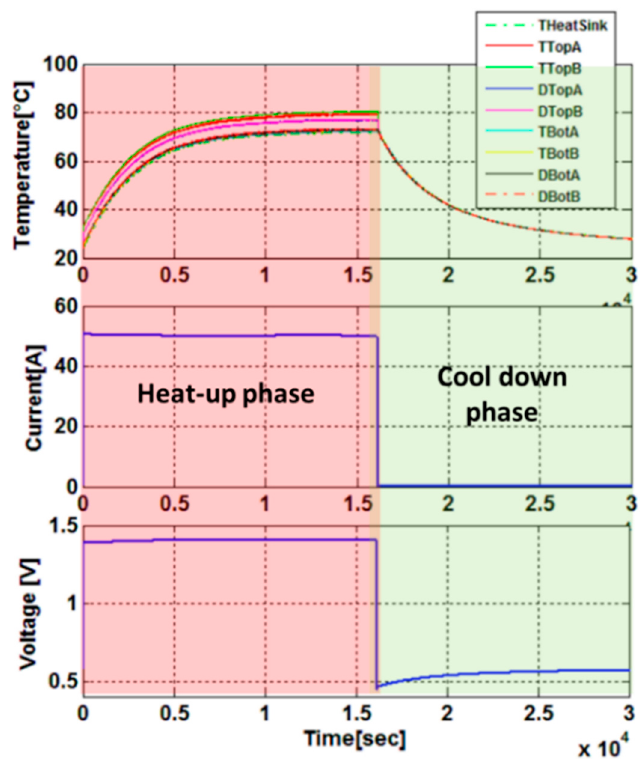
Figure 3. Temperature, current, and voltage profiles during measurement .